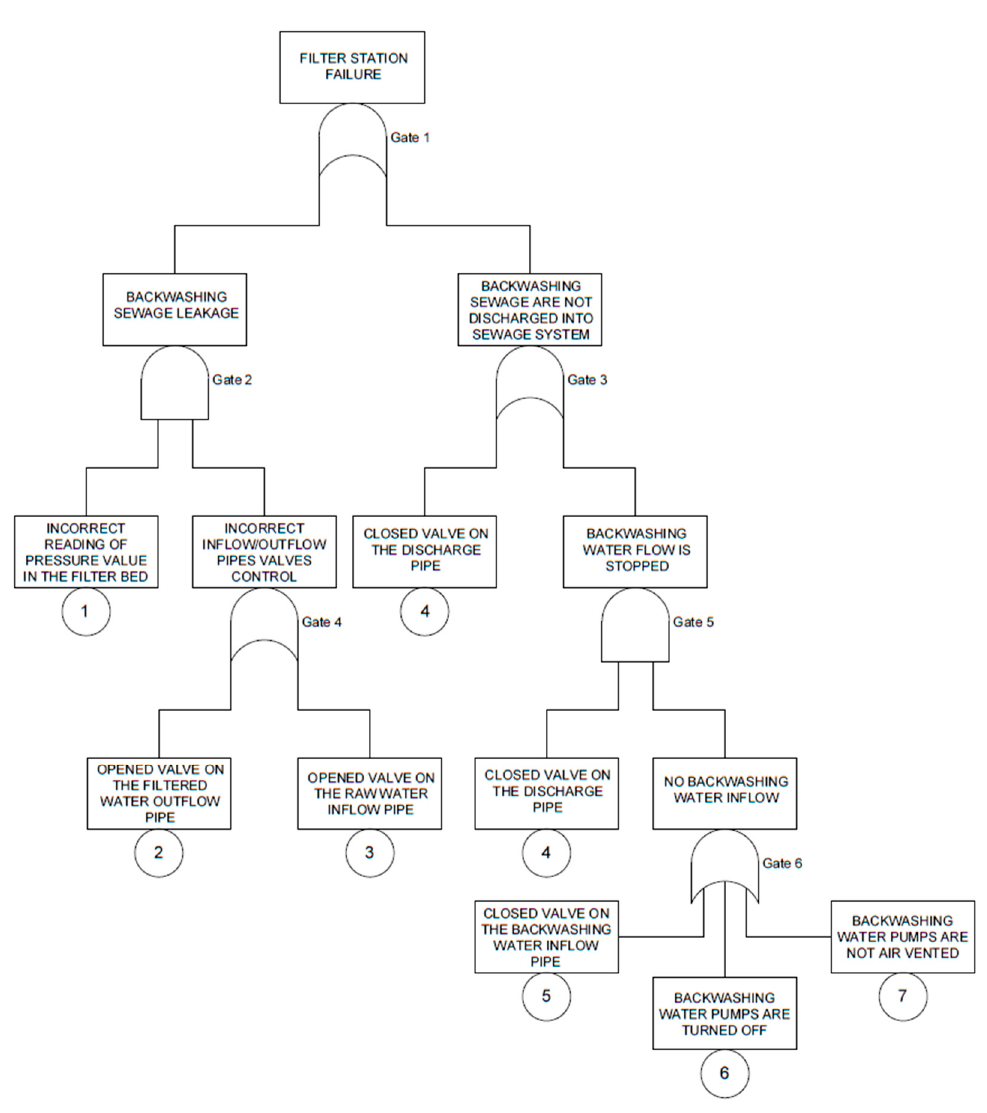
Figure 4. Fault tree for the operator actions during water filter backwashing procedure.